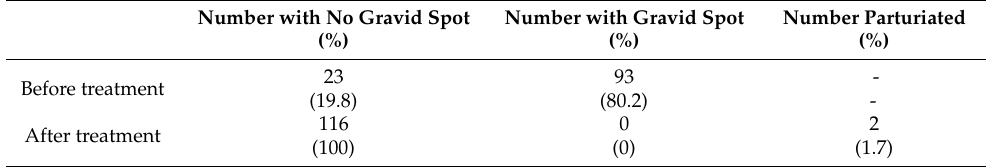
Table 3. The number of females with or without a gravid spot before and after MT treatment and those parturiated post